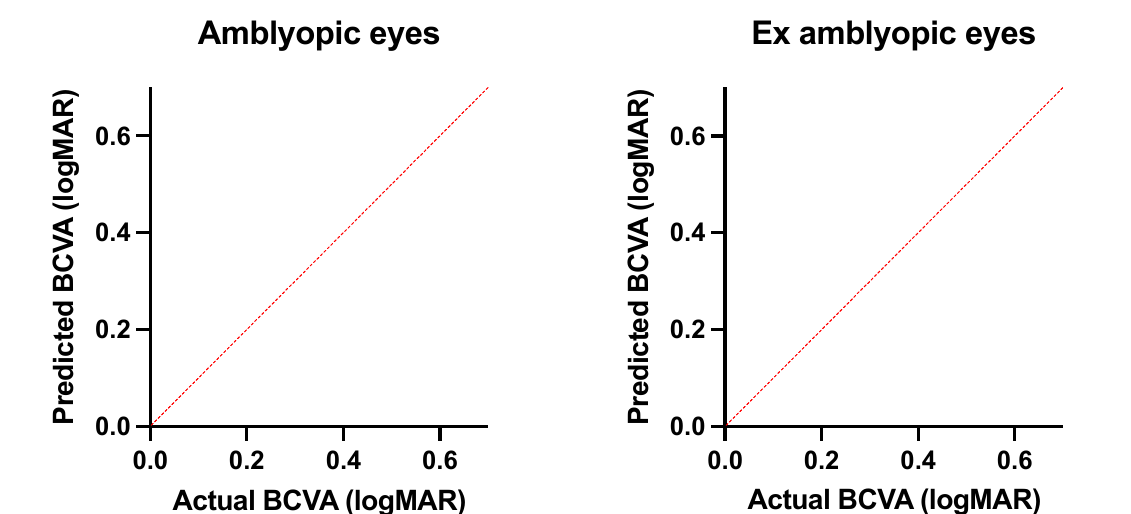
Figure 4. BCVA prediction model based on multiple linear regression of statistically significant OCTA variables in the study groups. The stronger the performance of the model, the closer the dots are to the bisector line. Both the proposed prediction models showed not only statistical significance ( p = 0.038 in amblyopic patients and p = 0.0095 in ex amblyopic patients) but also a good performance (R 2 = 0.94 for amblyopic patients and R 2 = 0.68 for ex amblyopic patients).